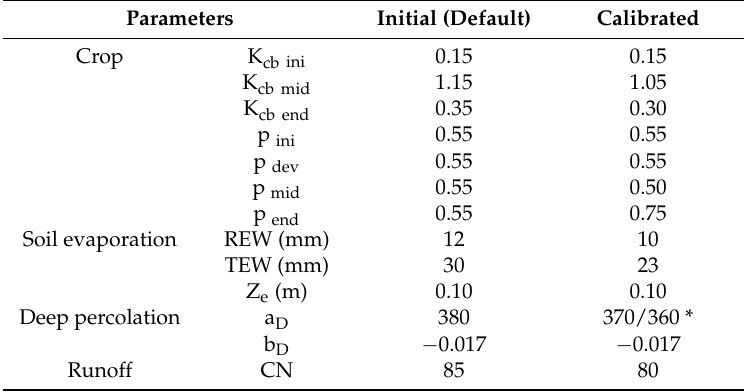
Table 6. Standard and calibrated basal crop coefficients (K cb ), depletion fractions for no stress (p), and parameters characterizing the soil evaporation layer, deep percolation and